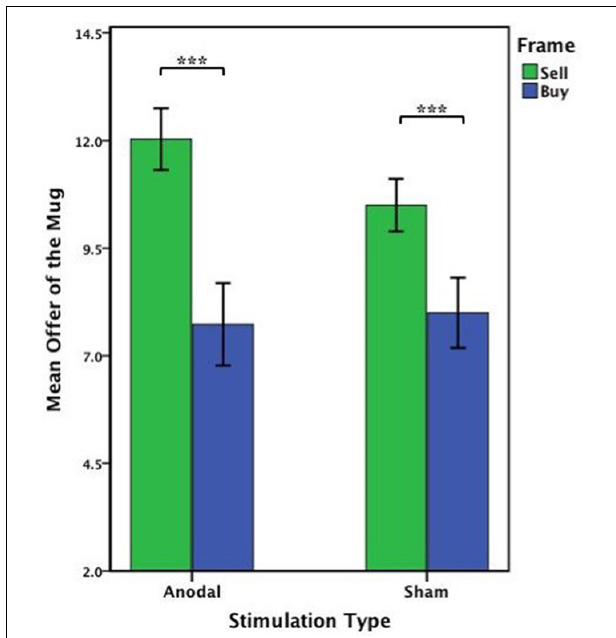
FIGURE 8 | Data of offer of the mug (Experiment 2). The mean offer of the mug across anodal or sham stimulation in each frame. Error bars indicate 95% confidence intervals. Asterisks indicate statistically significant difference between WTA and WTP.